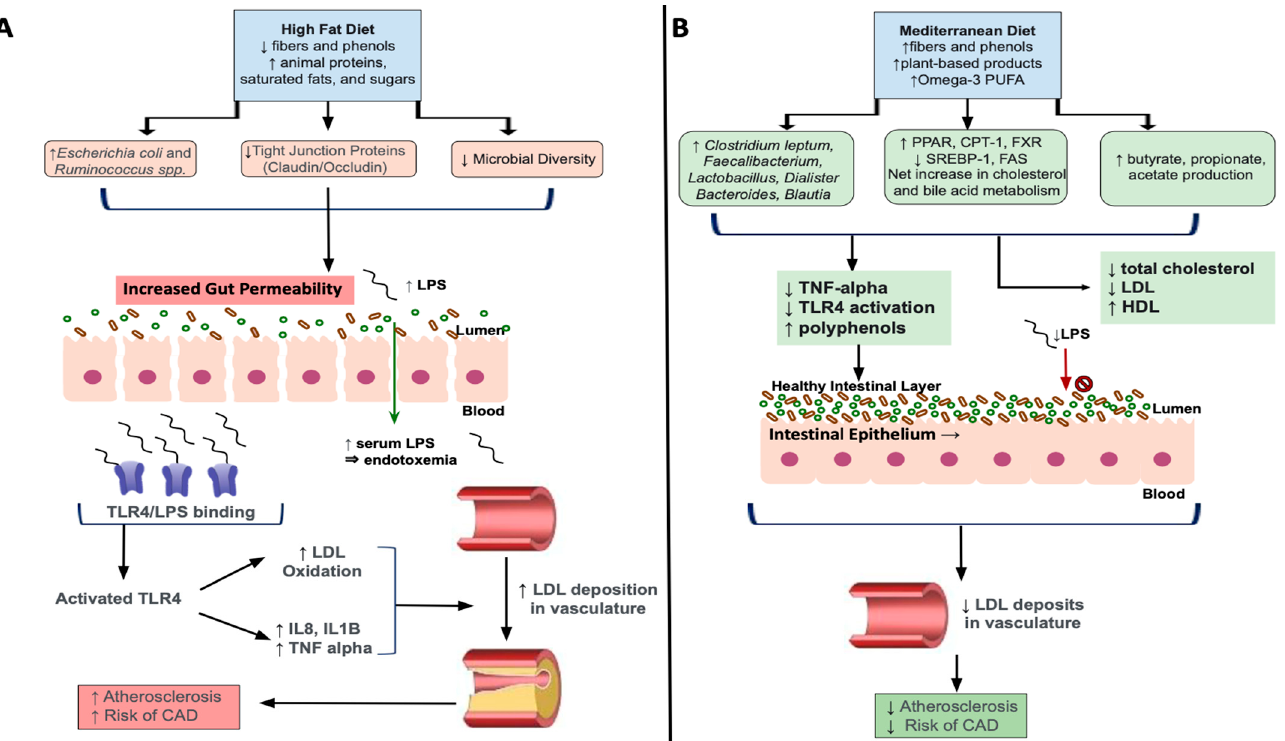
Figure 2 . Effects of a High-Fat Diet and a Mediterranean Diet on Dyslipidemia and Atherosclerosis. ( A ) The High-Fat Diet is composed of large quantities of animal proteins, saturated fats and sugars with decreased fibers and phenols. HFD feeding increase Gram-negative bacteria Ruminococcus and Escherichia spp. while intestinal tight junction proteins occludin and claudin and microbial diversity are reduced. This leads to increased gut permeability, LPS enters the blood stream, resulting in metabolic endotoxemia. Lipopolysaccharides bind TLR-4 on circulating host cells to increase pro-inflammatory cytokines, increased inflammation and reactive oxygen species. Oxidized LDL builds up, causing plaques and increased risk of atherosclerosis. ( B ) The Mediterranean diet is rich in fibers and phenols, plant-based products, and omega-3 poly-unsaturated fatty acids. The MD increase Clostridium leptum and key genera Faecalibacterium , Lactobacillus , Dialister , Bacteroides , Dialister , Bacteroides and Blautia. It increases SCFA, while upregulating cholesterol and bile acid metabolism by increasing PPAR, CPT-1, FXR activity and decreasing SREBP-1 and FAS activity. This lead to decreased TNF-alpha, TLR4 activation, total cholesterol and LDL, increase HDL and supports intestinal barrier integrity. Less LDL builds up, lessening atherosclerosis and CAD risk. Abbreviations: LPS, Lipopolysaccharides; TLR4, Toll-like receptor 4; LDL, Low-density lipoprotein; IL, interleukin; TNF, Tumor necrosis factor; CAD, coronary artery disease; PUFA, poly-unsaturated fatty acids; PPAR, Peroxisome proliferator activated receptor; CPT-1, Carnitine palmitoyl transferase I; SREBP-1, sterol-regulatory element-binding protein 1; FAS, fatty-acid synthase; HDL, High-density lipoprotein.